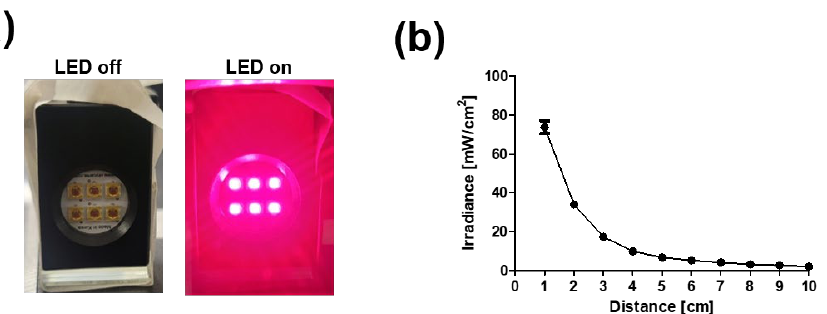
Figure 1. Development of light emitting diode (LED) device for PBM. ( a ) Photograph image of array of chip LED module. ( b ) Irradiance power of device vs. distance.